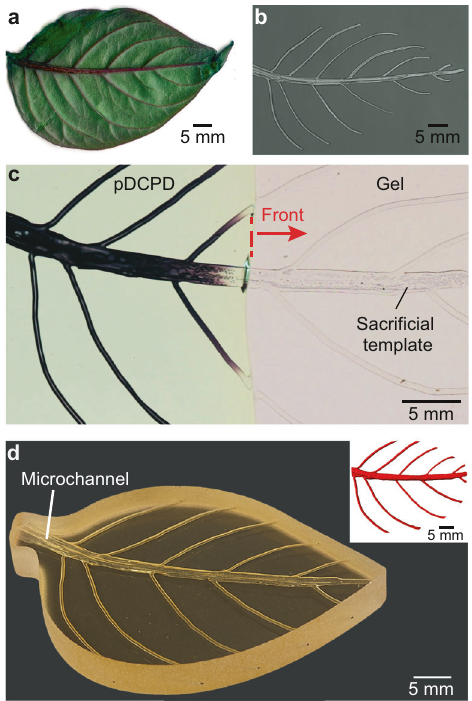
Fig. 4 Synchronized manufacturing of a structure with hierarchical vascular network. a An Impatiens leaf. b 3D-printed PPC (1% PAG) template referencing veins of leaf in a . c Simultaneous polymerization and vascularization of DCPD gel ( α 0 = 0.25) with the embedded 3D-printed PPC (1% PAG) template. Depolymerization products escape through the central vein, completing the vascularization process in 80 s. d Optical image of the vascular structure and its µ CT reconstruction (inset) show interconnectivity in the resulting